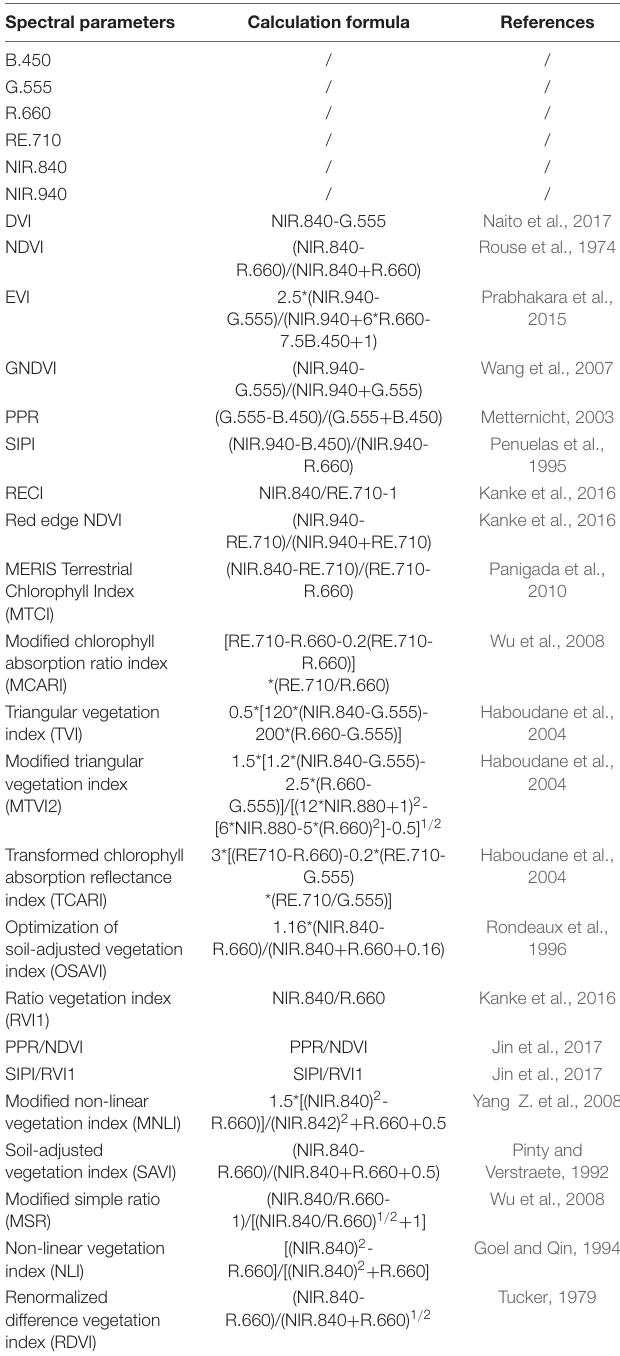
TABLE 2 | The spectral parameters used in this